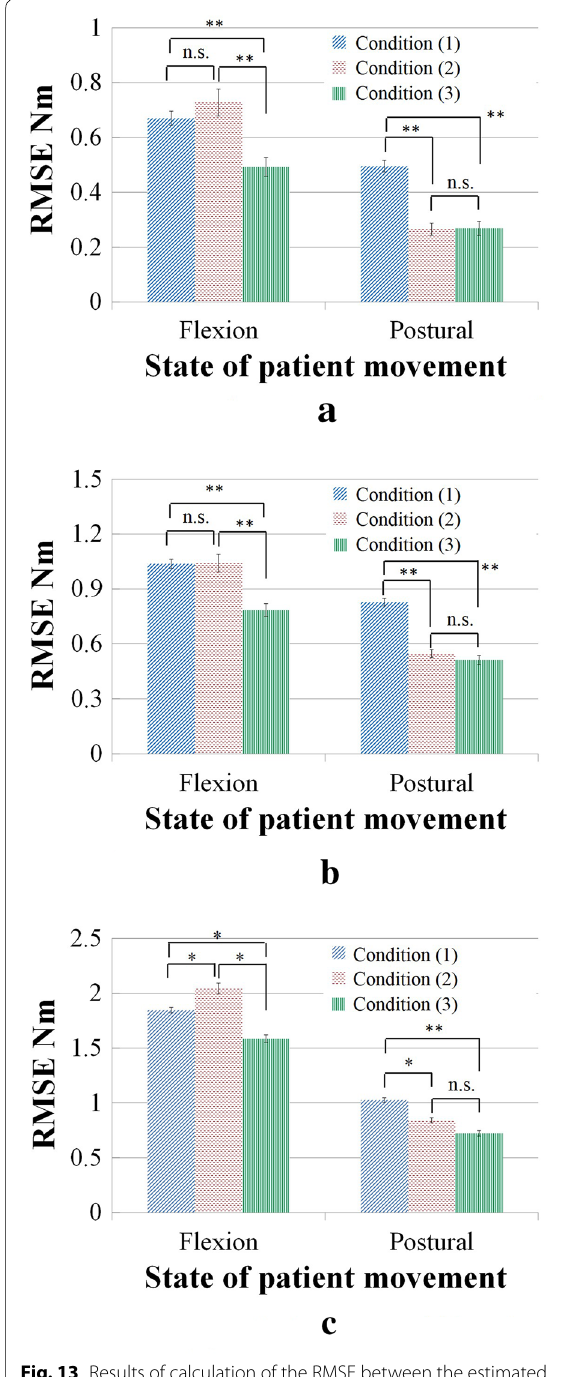
Fig. 13 Results of calculation of the RMSE between the estimated data and the ground truth data. Data were statistically compared with one another using Bonferroni correction. The significance levels were adjusted based on the number of groups (the three conditions) as follows: * p < 0.0167 ( 0.05/3), ** p < 0.0033 ( 0.01/3). a Patient = = holding an empty bottle. b Patient holding a half-full bottle. c Patient holding a full bottle